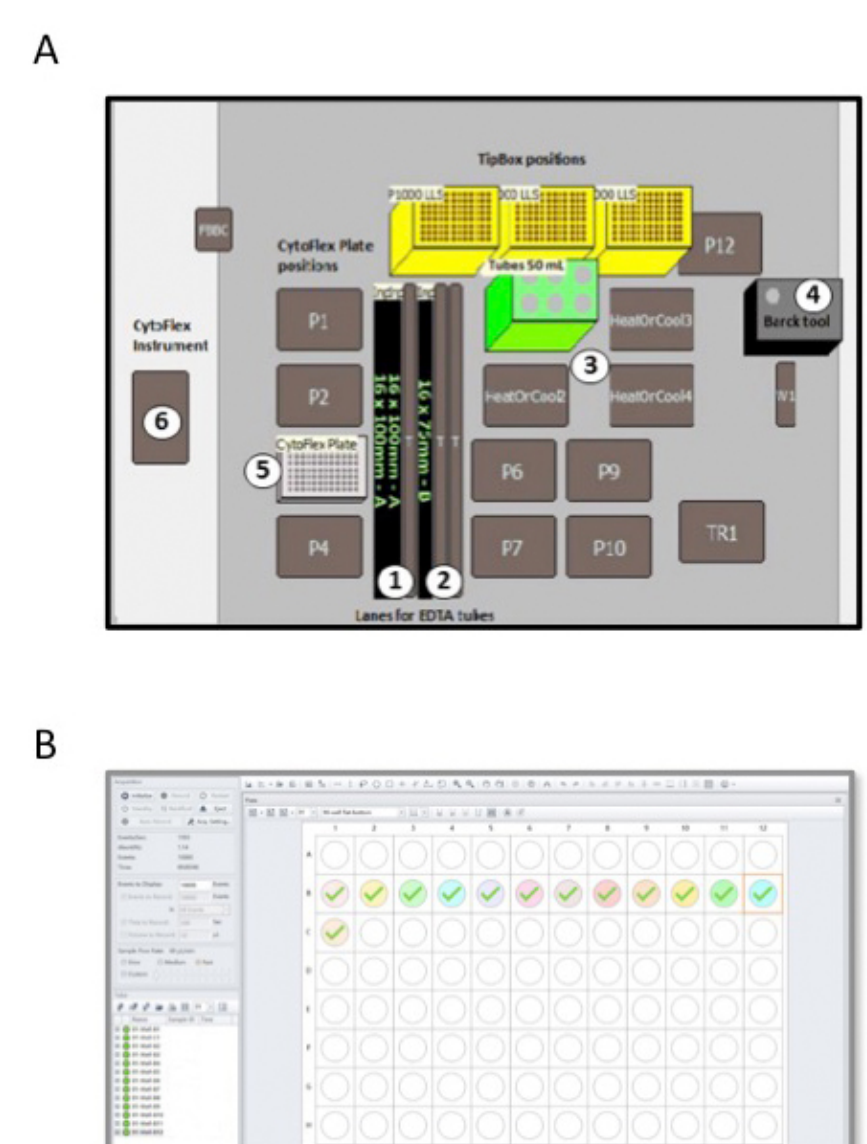
Figure 2. Scheme of the Biomek i-5 Automated Workstations (A) integrated with the CytoFLEX Flow